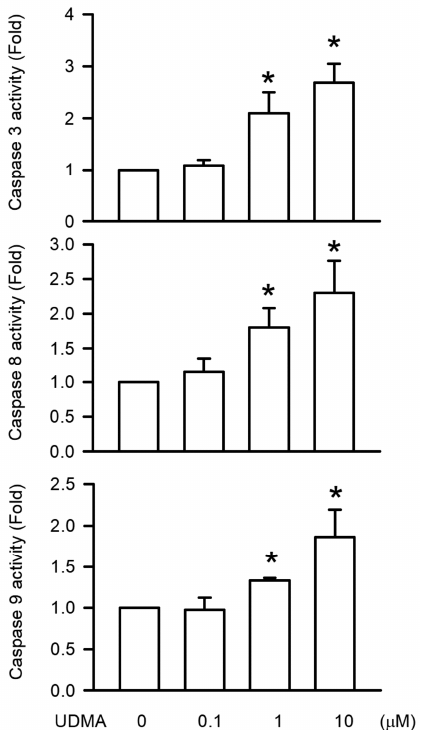
Figure 5. UDMA-induced caspase-3, -8, and -9 activation in RAW264.7 macrophages. Data are expressed as mean ± SD (n = 5). * P < 0.05 is considered significant compared with the control group.